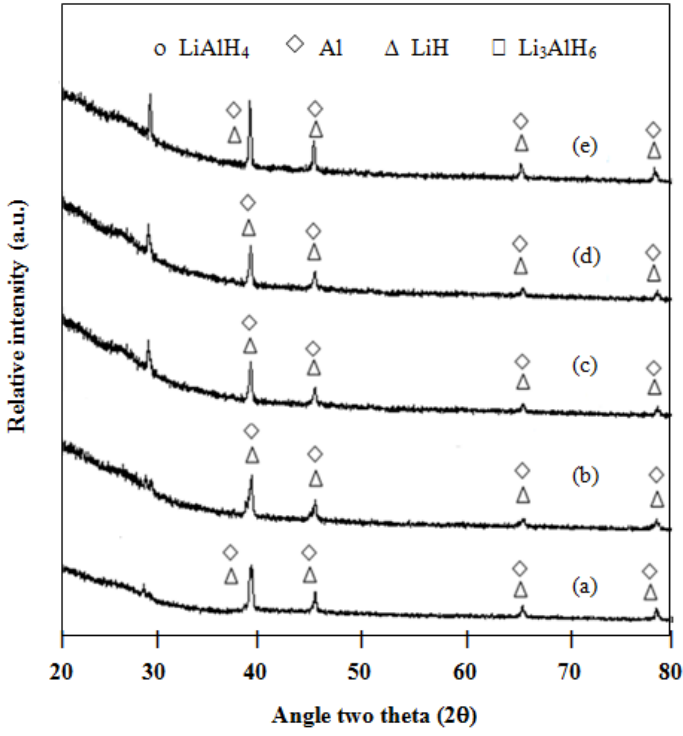
Figure 5. XRD patterns of desorbed samples at 300 °C: ( a ) 2LiAlH ( b ) 1 mol % ZrCl TiCl –2LiAlH 3